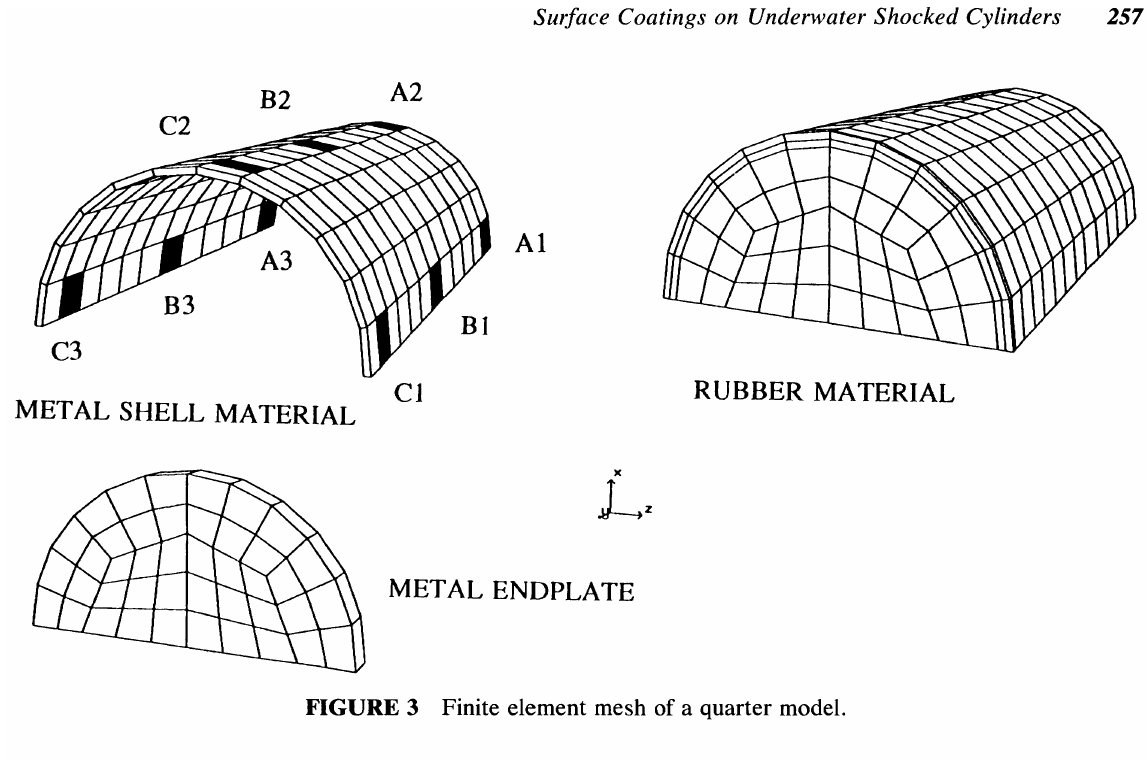
FIGURE 3 Finite element mesh of a quarter model.